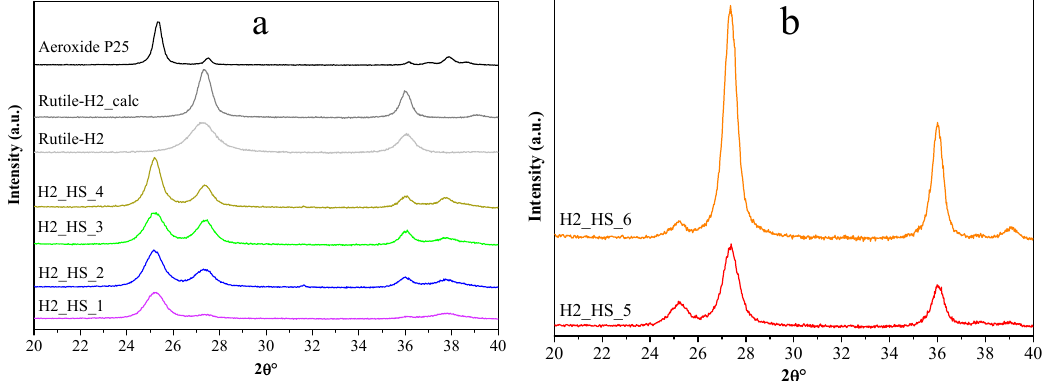
Figure 7. X-ray di ff raction patterns of our own anatase phase and reference TiO 2 -s ( a ) and our own rutile phase TiO 2 -s ( b ).